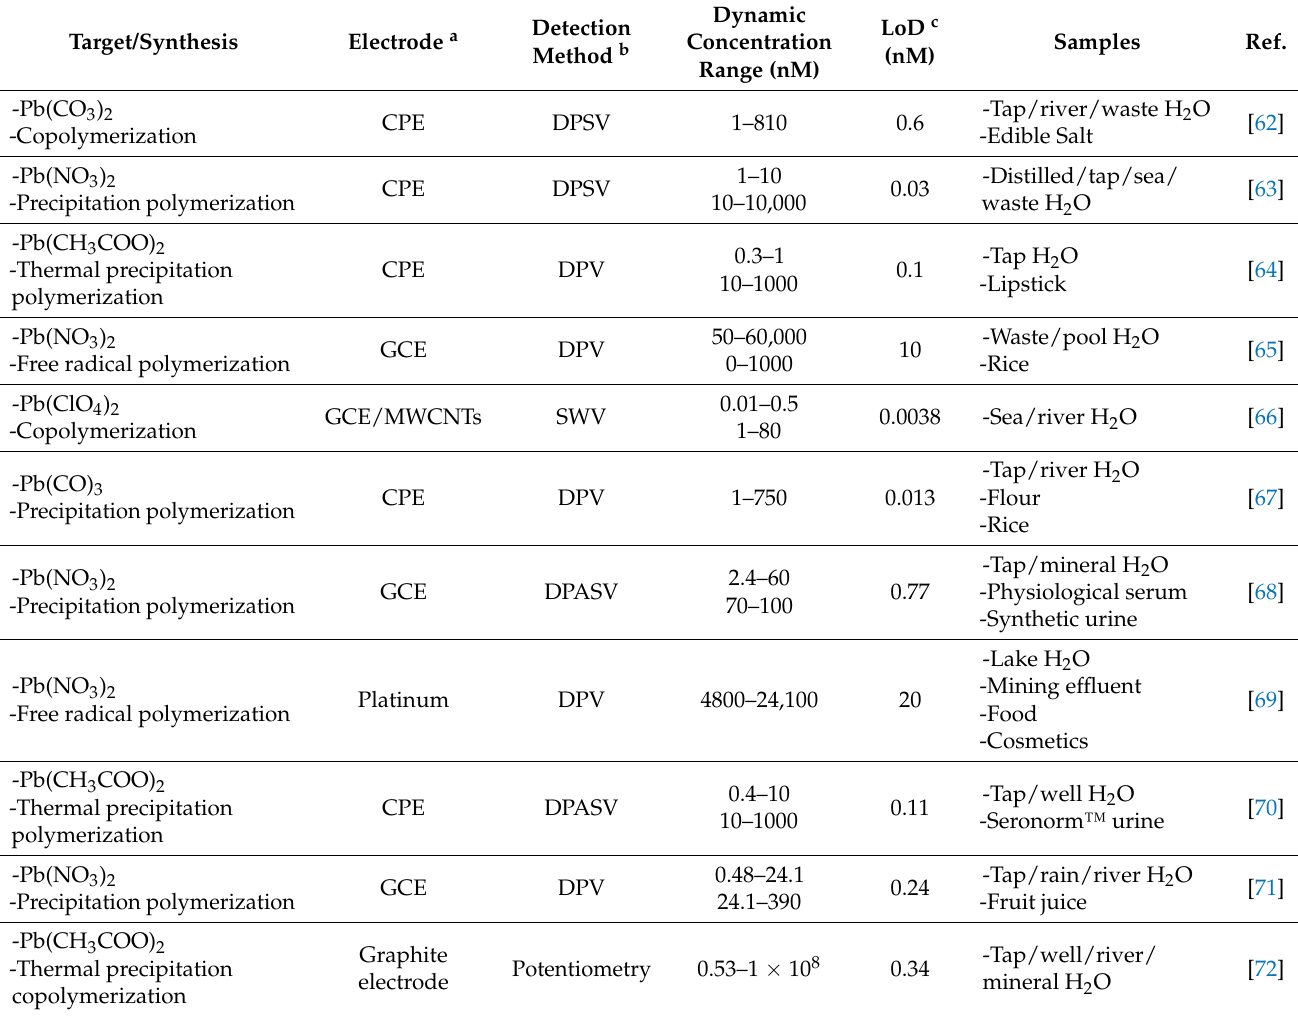
Table 2. Summary of studies which have utilized IIPs for the electrochemical detection of